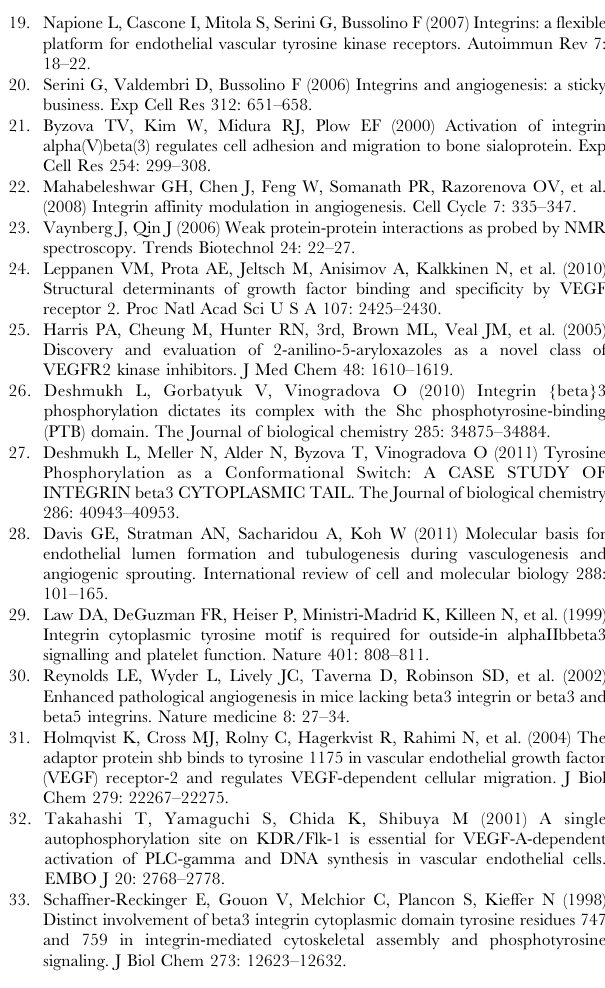
Supporting Information Figure S1 Sequential connectivity map for VpepB. Figure is produced by CCPN Analysis 2.1.1. (JPG) Figure S2 Uptake of b 3 CT derived peptides by EC. Peptides were labeled with fluorescein (green) at the N- termini and added to HUVEC growth media for the indicated times. The plasma membranes were labeled with Dil (red) and nuclei stained with DAPI (blue). The cells were fixed and analyzed by confocal microscopy. (JPG) Figure S3 bFGF induced signaling events are not affected by F747 or pY747 peptides. HUVEC cells pretreated with peptides as indicated and stimulated with bFGF for 30 min. Total cell lysates were immuno-probed with anti phospho-erk